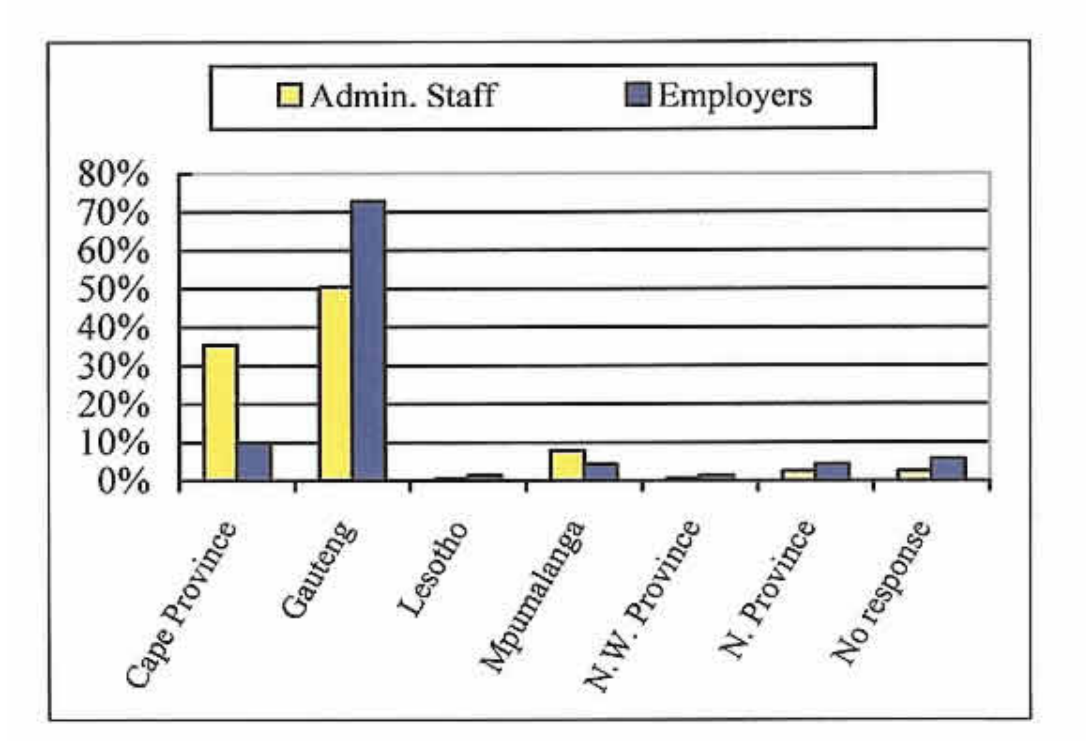
Figure 3 Geographic demarcation: administrative staff and